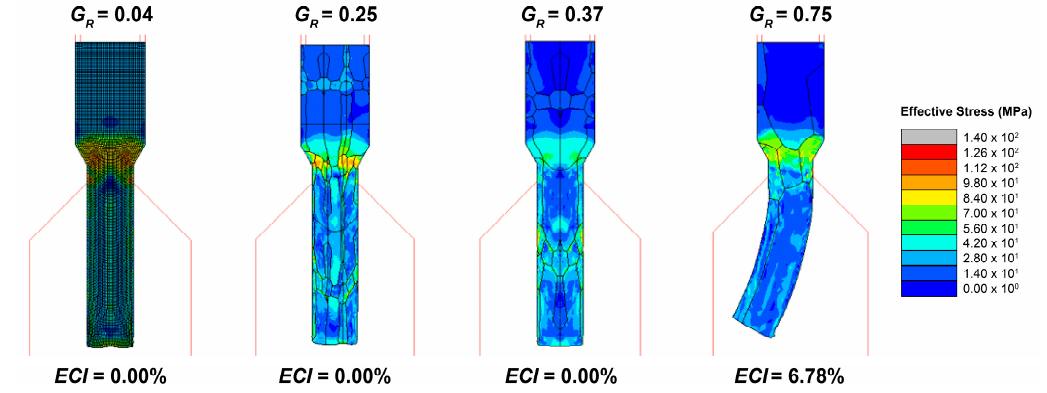
Figure 20. The results comparison among different grain sizes.